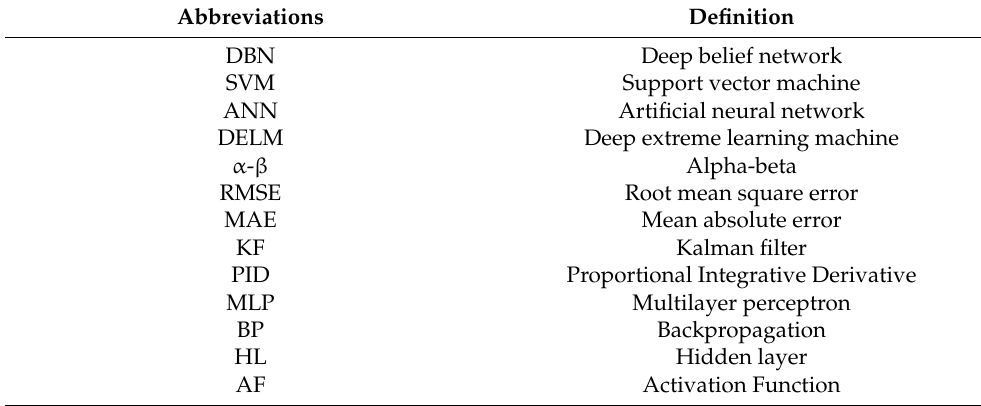
Table 1. Notations with